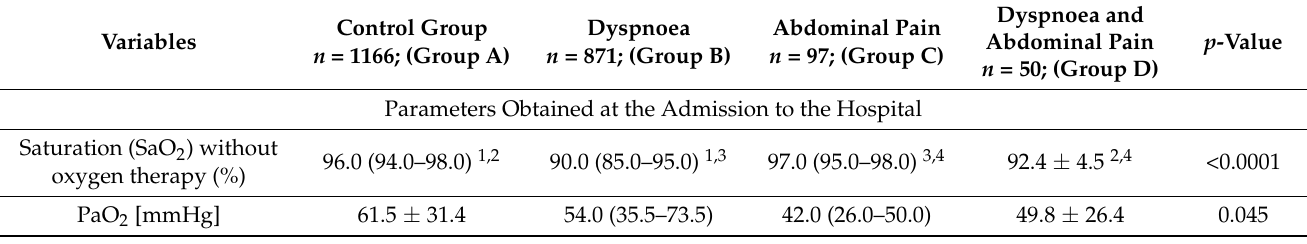
Table 2. Comparison of the clinical and laboratory parameters in four tested groups of patients with COVID-19 at the time of admission to hospital and during